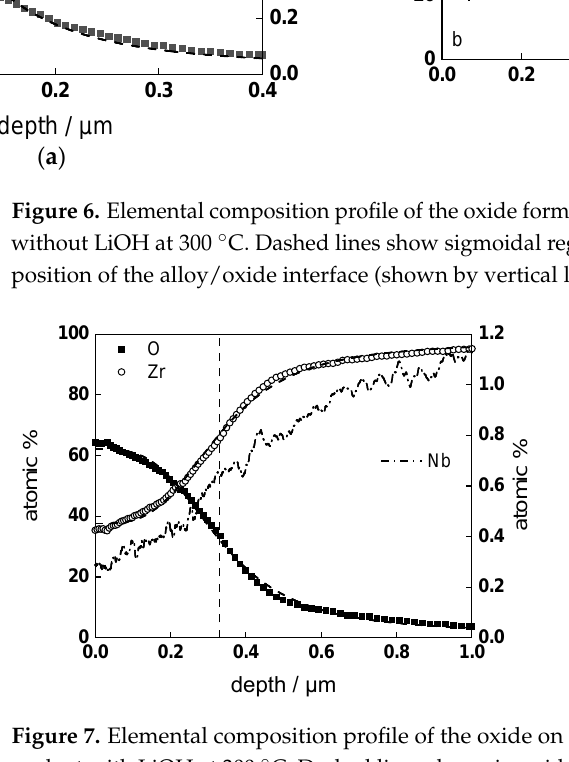
mode) in WWER coolant without LiOH at 300 ◦ C depending on the oxidation time. Left ordinate-